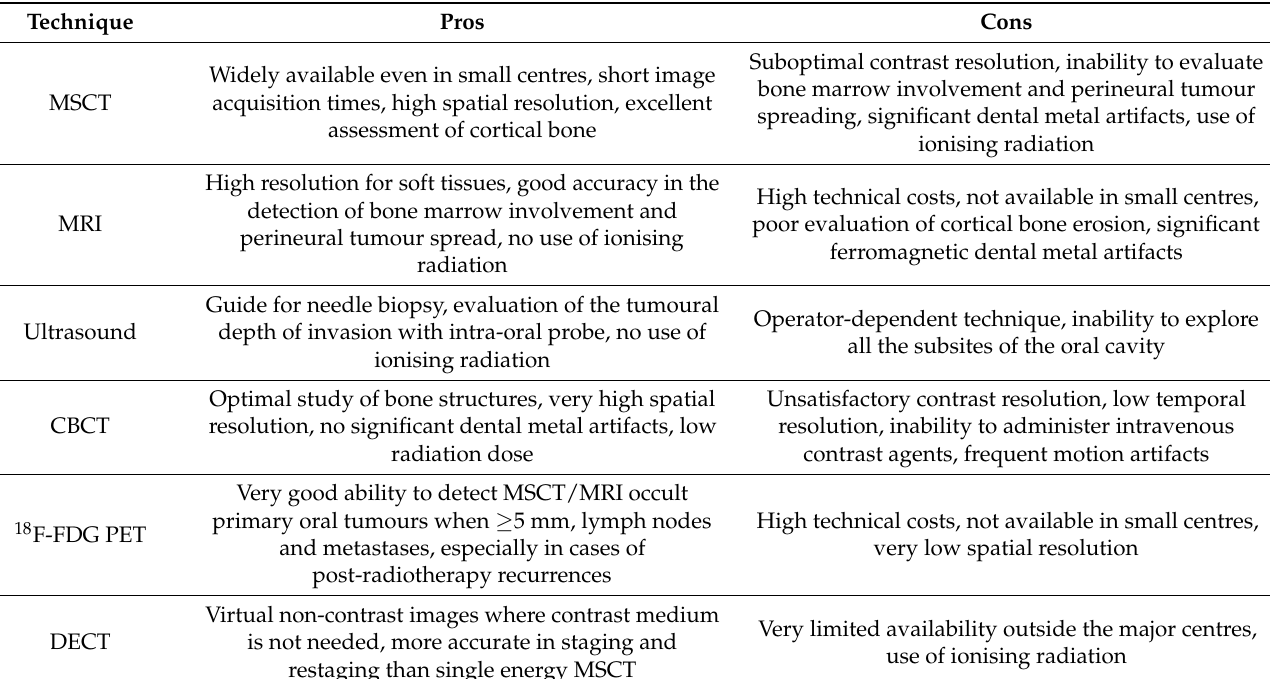
Table 1. Pro and cons of the imaging techniques used for the study of oral